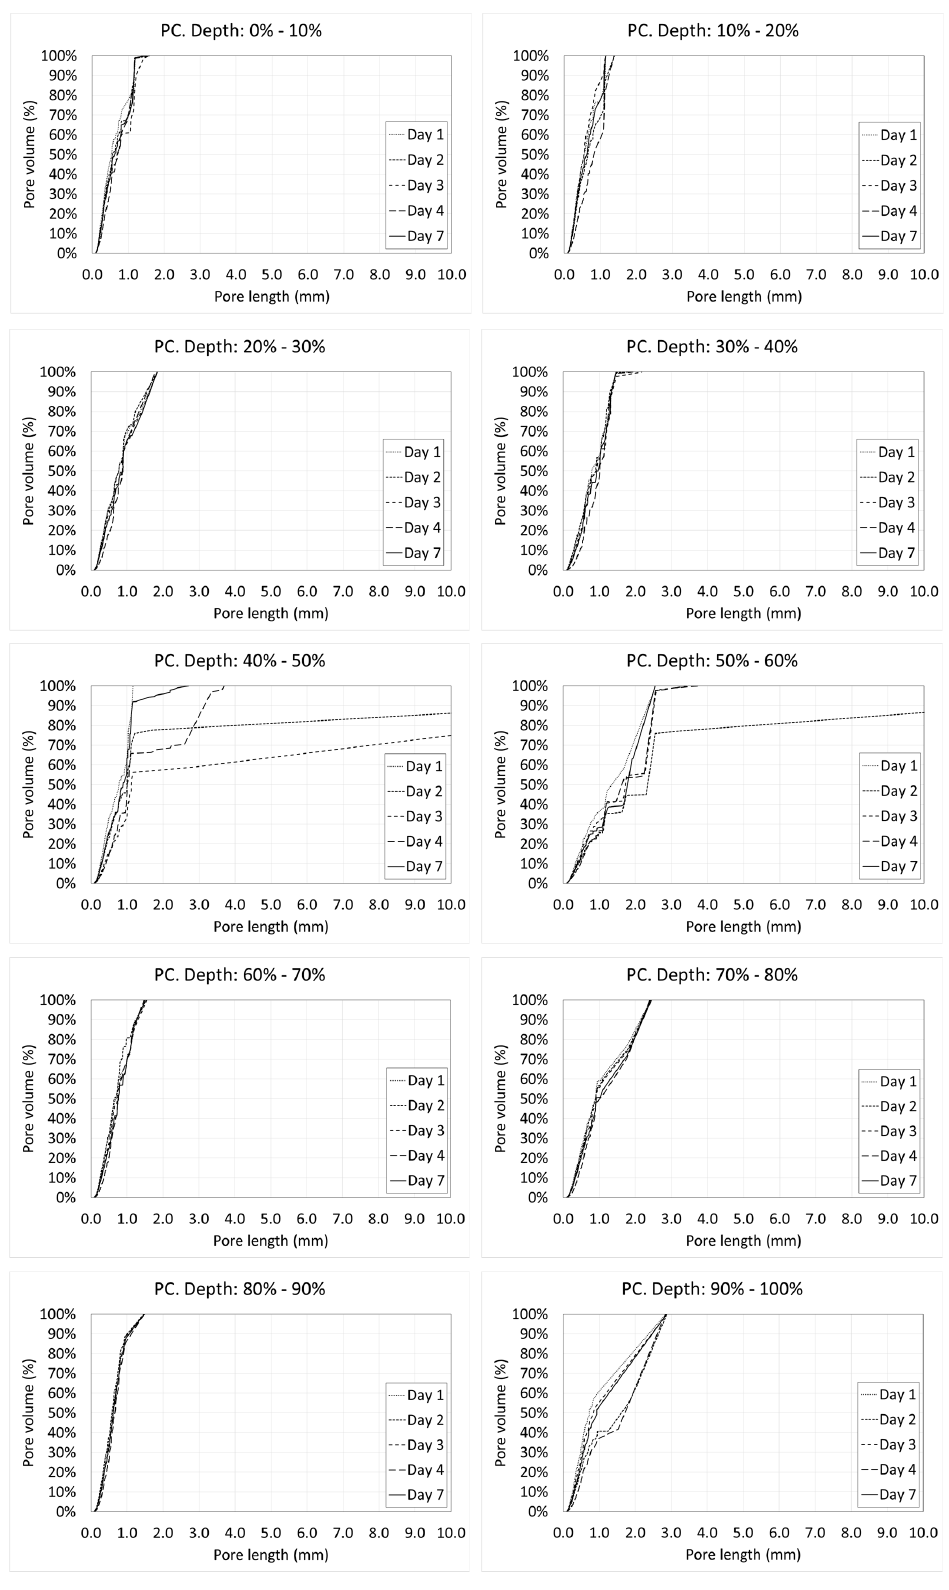
Figure 19. Porosimetric curves of PC at different ages and depths.